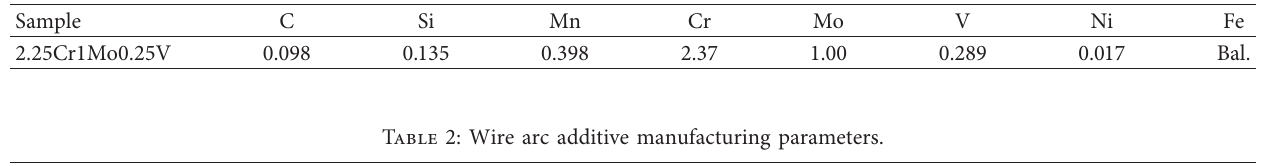
Table 1: Chemical composition (wt%) of the 2.25Cr1Mo0.25V solid